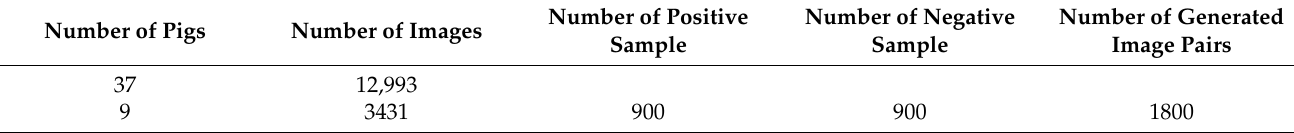
Figure 1. Pig face dataset. Table 1. Results of the processed pig face